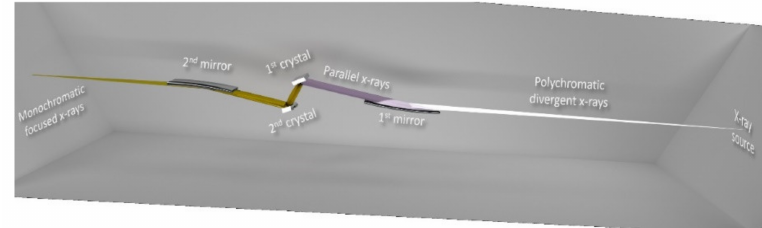
Figure 1. Sketch and description of the diffraction diffusion anomale multi-longueur d’onde (D2AM) beamline optical and focusing elements of the optics